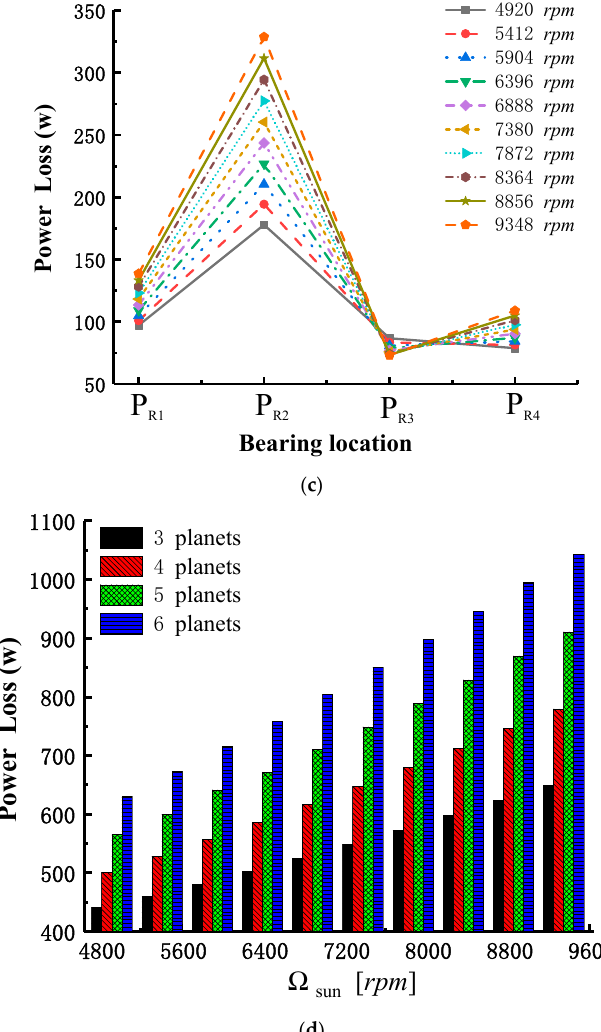
Figure 16. Variation of power loss with input speed. ( a ) Frictional power loss on tooth surface; ( b ) windage power loss; ( c ) bearing power loss at different positions; ( d ) bearing friction power loss. Appl. Sci. 2020 , 10 , x FOR PEER REVIEW